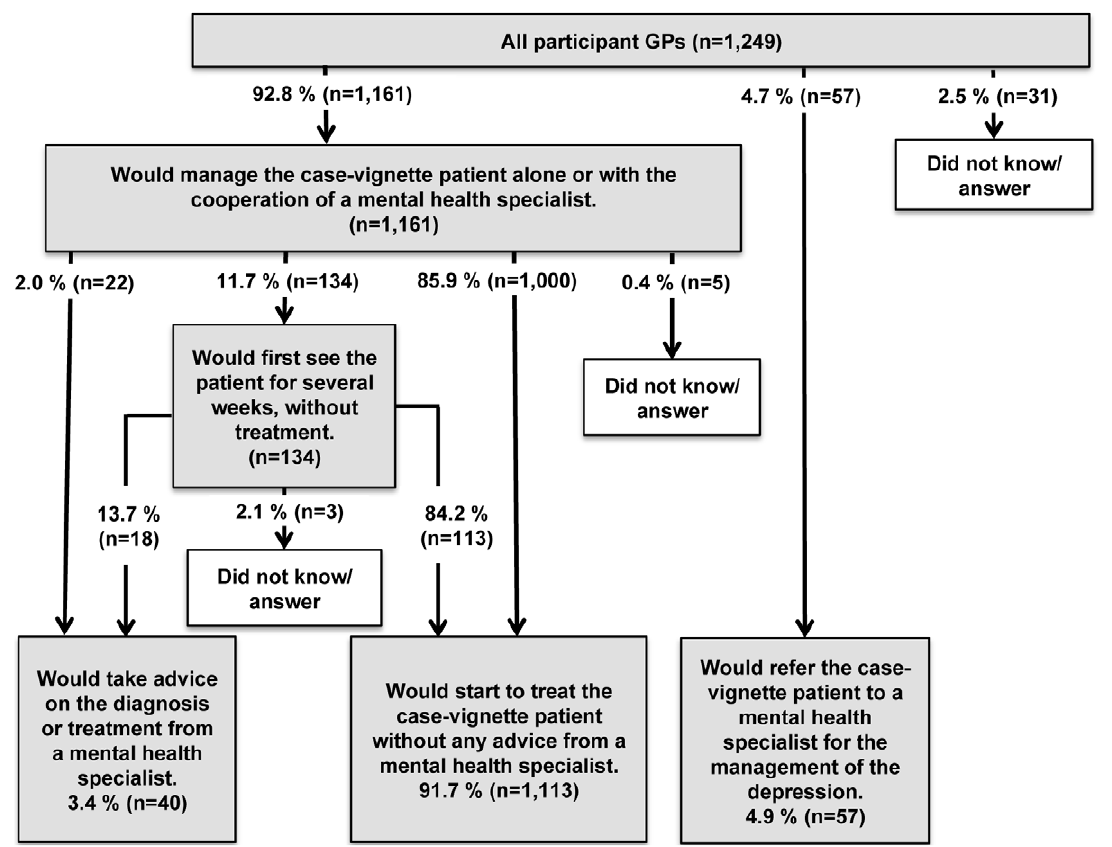
Figure 1. Initial management of the case-vignette patients with major depression by GPs (Weighted data, N=1,249).